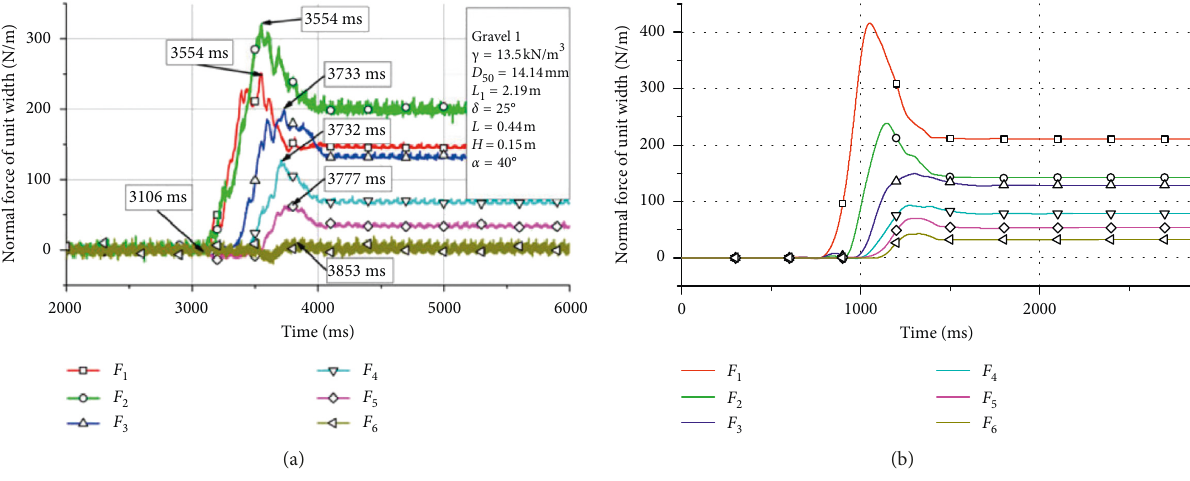
Figure 5: Time history of the unit-width normal force ( L 44- H 15- α 40 ° ): (a) the experimental data [45]; (b) the numerical results